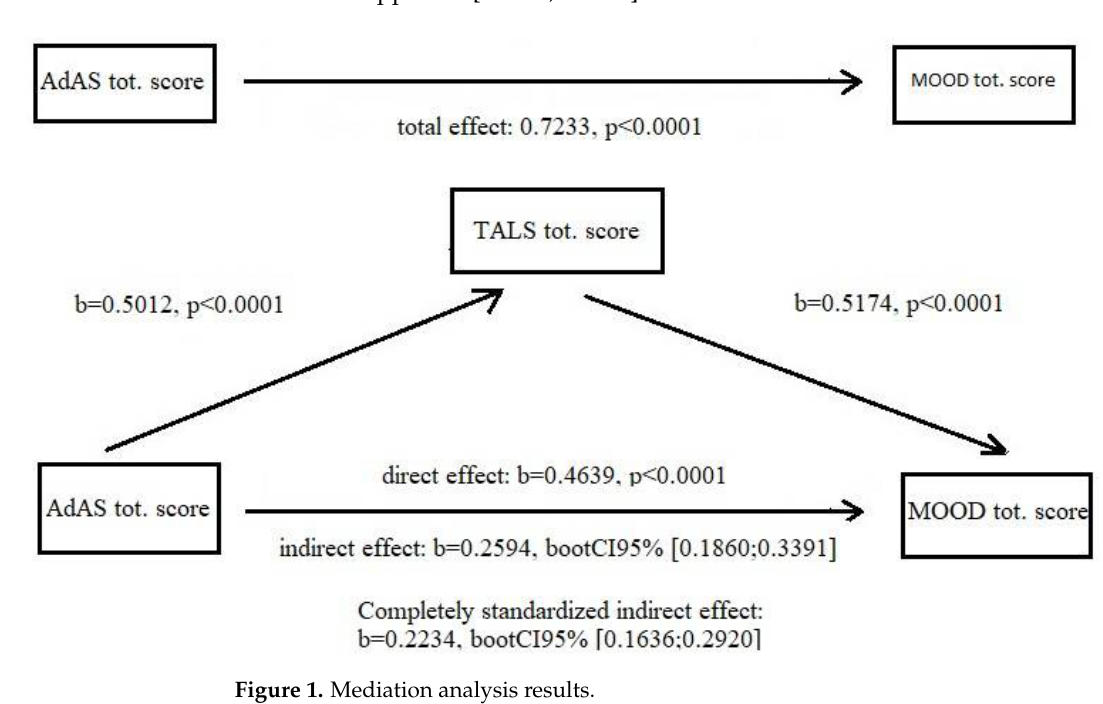
Figure 1. Mediation analysis results.